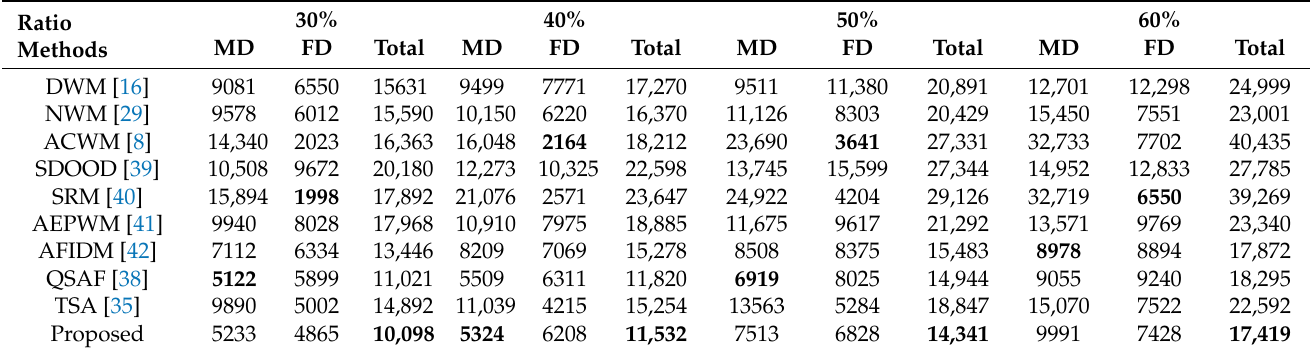
Table 1. Detection results comparison of different methods for Lena image when corrupted with 30% to 60% RVIN.